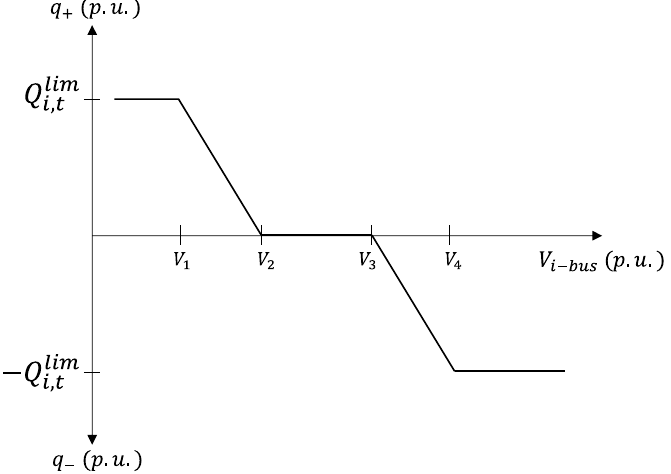
Figure 2. Volt–var curve for each inverter.